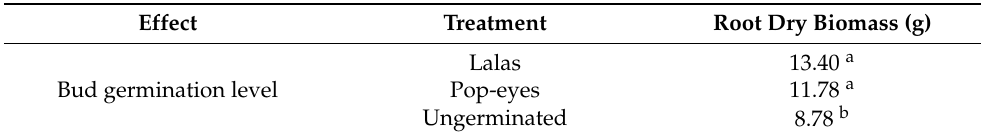
Table 7. Root dry biomass in different sugarcane bud germination levels in second greenhouse experiment a .